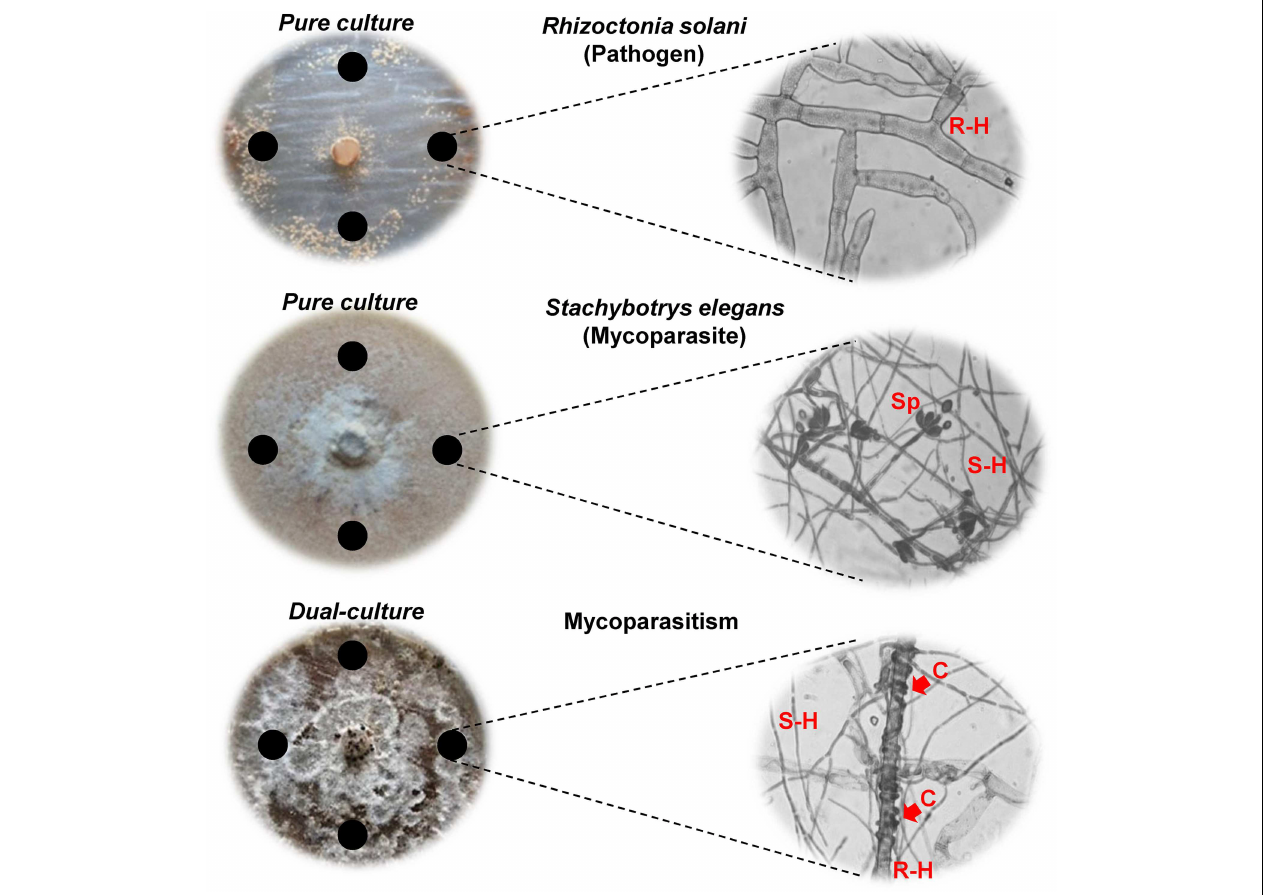
FIGURE 1 | R. solani and S. elegans in pure and dual-cultures are displayed after 4 days (D4) of growth with corresponding microscope images of hyphae (40X). Arrows indicate the formation of coils (C) of S. elegans (S-H) on R. solani (R-H) hyphae. Black circles indicate the locations of sampling (Sp; spores).